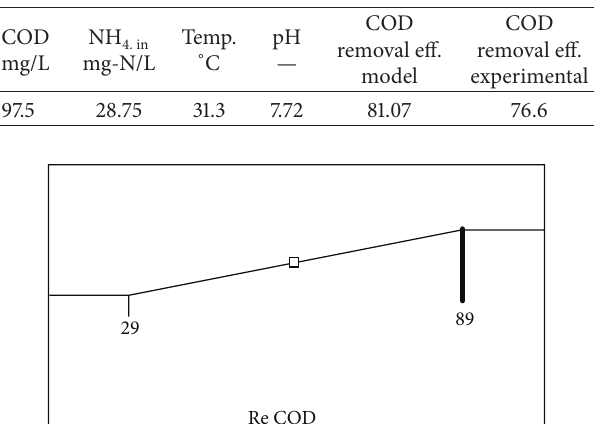
Figure 6: Rams functions and optimal